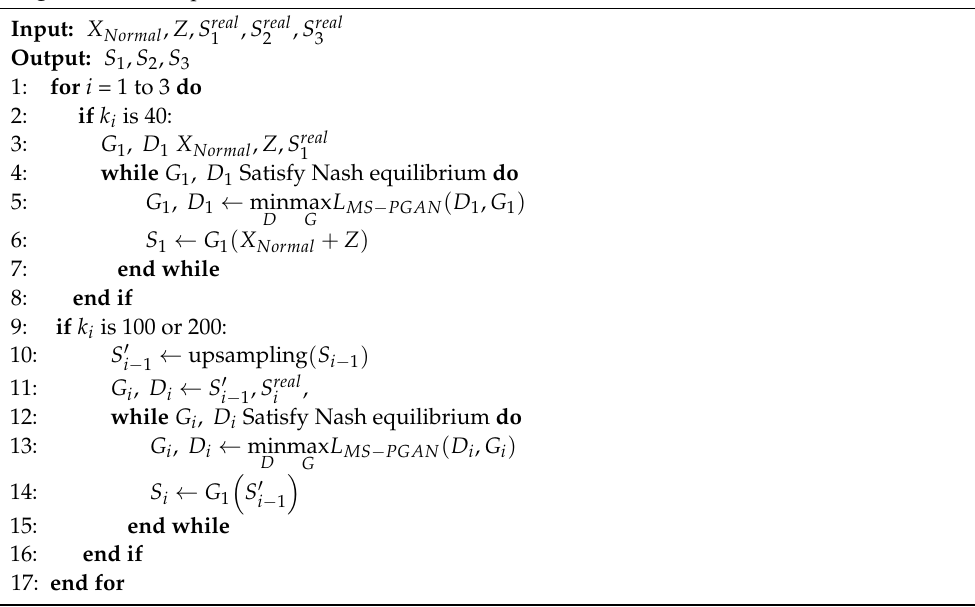
Algorithm 1. The procedure of